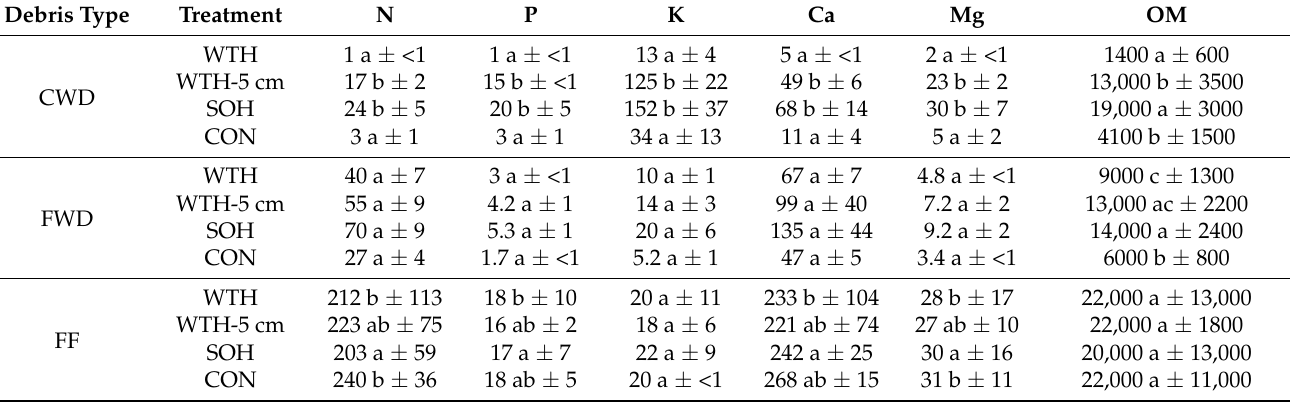
Table A1. Coarse and fine woody debris pools by harvest type (CON = control, SOH = stem-only harvest, WTH-5 cm = whole-tree harvest up to 5 cm, WTH = whole-tree harvest) and forest floor values post-harvest where differences in lower-case letters denote significant differences derived from tables 8, 9, 10 in [9].